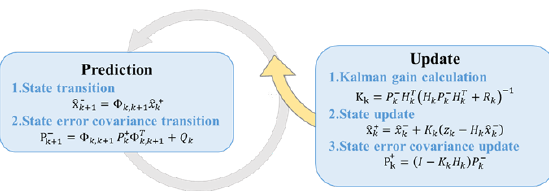
Figure 5. Flow chart of time-discrete KF